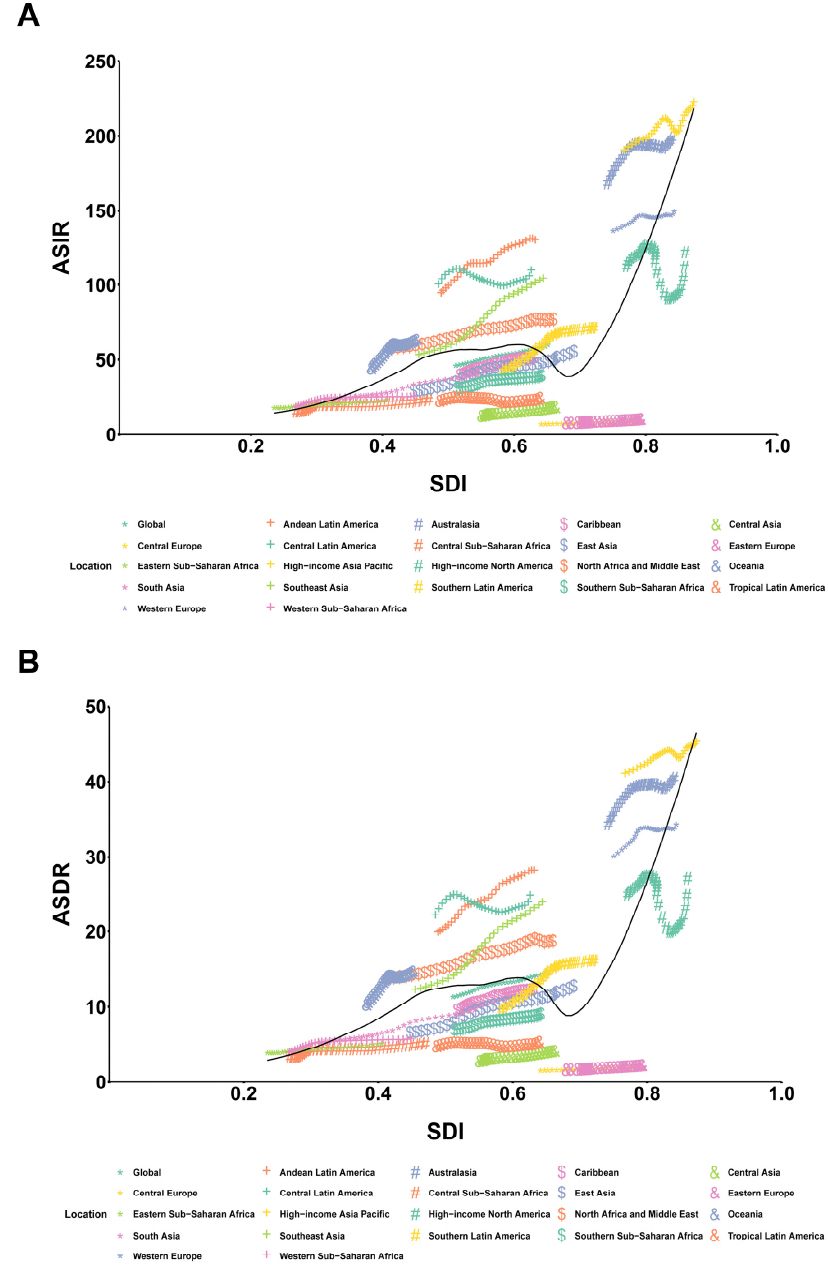
Figure 4. Cont 1